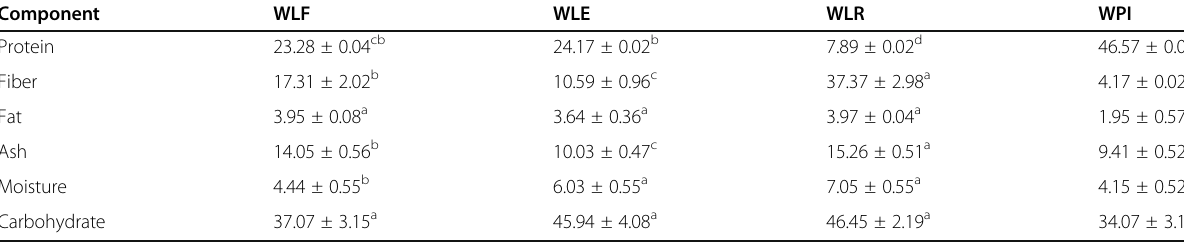
Table 1 Proximate composition (g/100 g DW) of African wild lettuce leaves Component